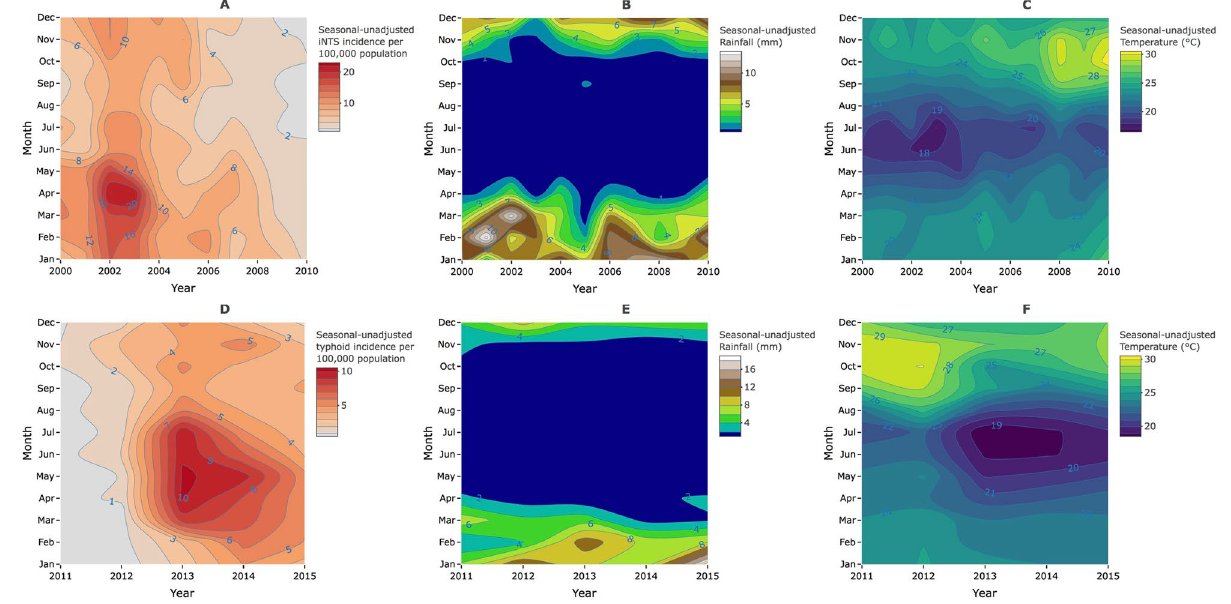
Figure 2. Seasonal dynamics of invasive Salmonella diseases. Contour plots of yearly and monthly changes in the incidence of nontyphoid Salmonella disease (iNTS), rainfall and temperature respectively ( A – C ) from 2000–2010; yearly and monthly changes in the incidence of typhoid, rainfall and temperature respectively ( D – F ) from 2011 to 2015 in Blantyre,